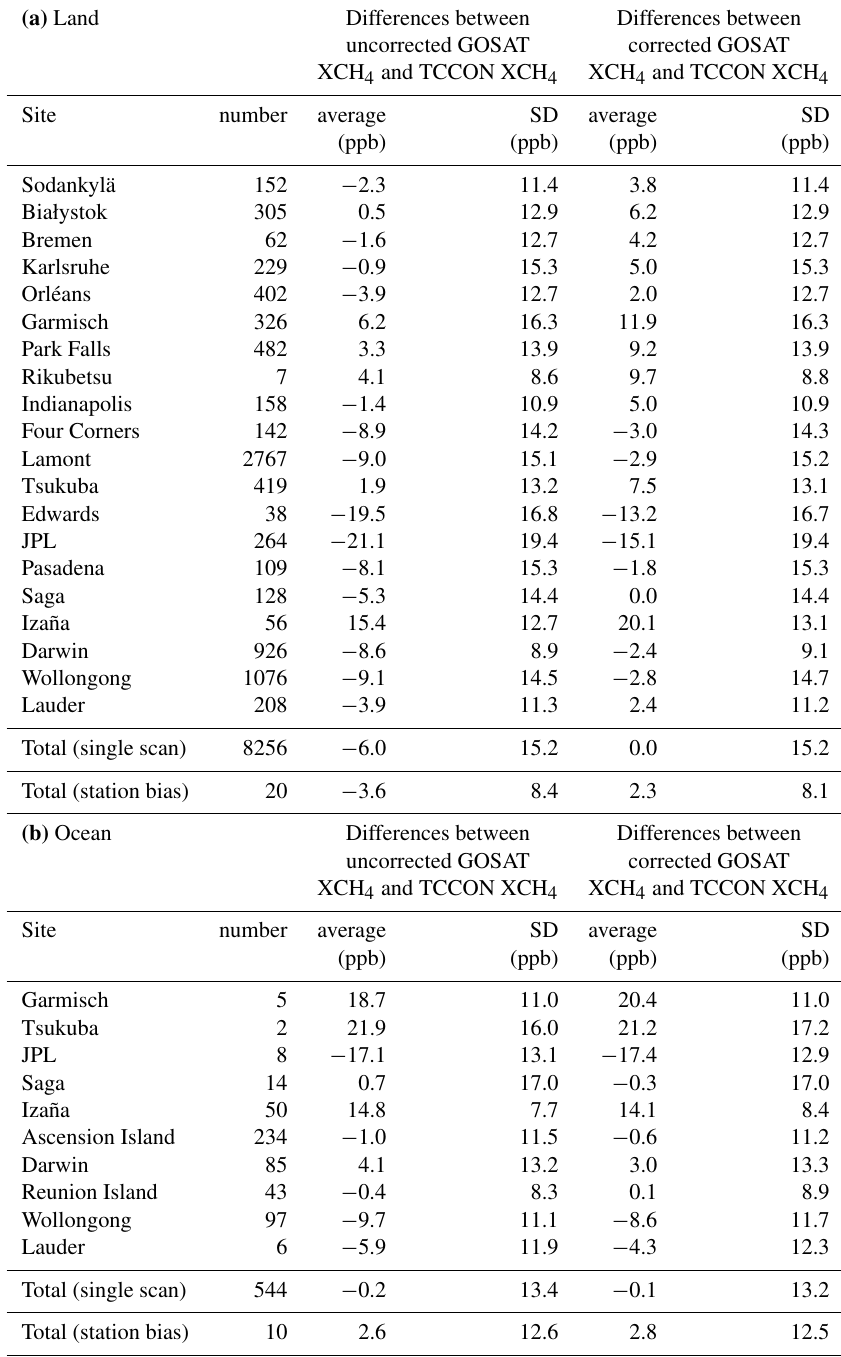
Table 5. The average and standard deviation of the differences between uncorrected/corrected GOSAT XCH 4 and TCCON XCH 4 at each TCCON site. The GOSAT data were retrieved over (a) land and (b) ocean regions within ± 5 ◦ latitude/longitude boxes centered at each site. The averages and standard deviations of the differences of the matched data at all TCCON sites (single scan) and those of the station biases are also shown in the second row from the bottom and the bottom row of the table,